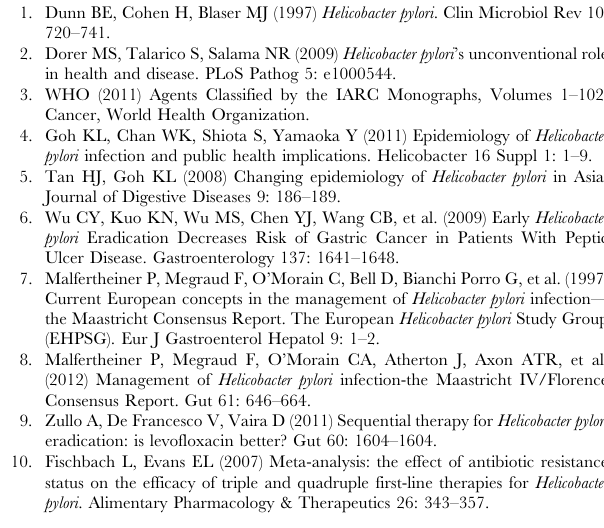
Figure S1 Premature truncation in peptide translation of rdxA . (DOCX) Figure S2 Alignment of peptide sequence with reference and sensitive strains for rdxA . (DOCX) Figure S3 Premature truncation in peptide translation of frxA . (DOCX) Figure S4 Alignment of peptide sequence with reference and sensitive strains for frxA . (DOCX) Figure S5 Alignment of nucleotides sequence with reference and sensitive strains for 23S rRNA . (DOCX) Figure S6 Alignment of peptide sequence with reference and sensitive strains for gyrA and gyrB